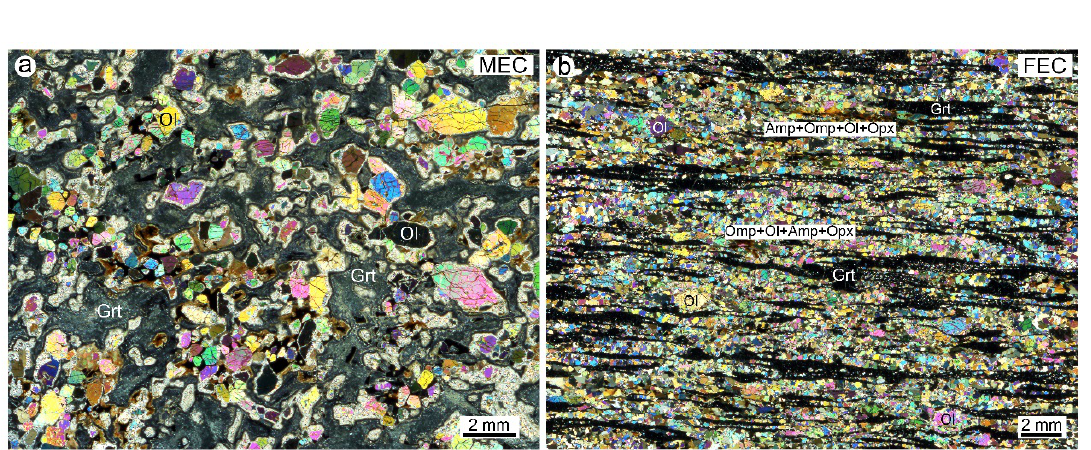
Figure 2. Optical photomicrographs under crossed polarizers showing the microstructures of ( a ) massive eclogite (MEC) and ( b ) foliated eclogite (FEC). Mineral abbreviations: olivine (Ol), garnet (Grt), amphibole (Amp), and orthopyroxene (Opx). Table 1. Normalized phase volume proportions (vol.%) based on electron backscatter diffraction (EBSD) mapping.